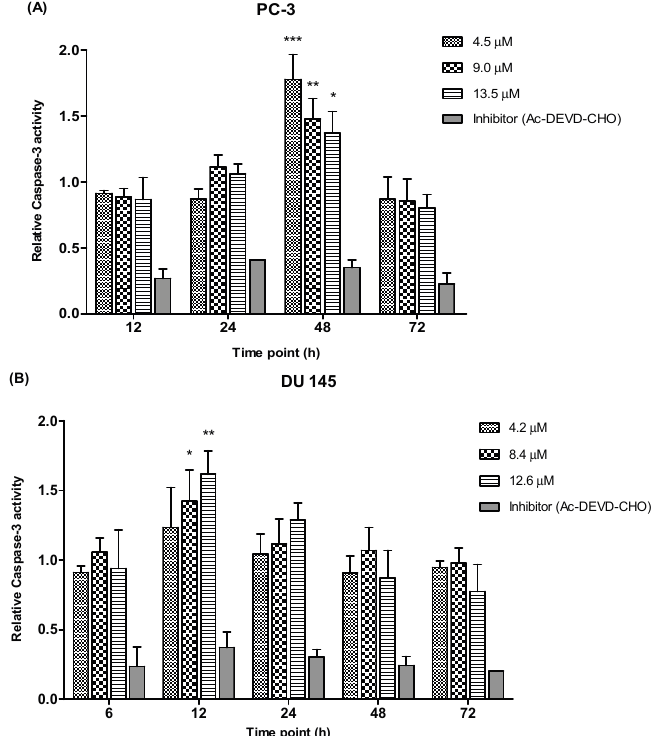
Figure 9. Relative caspase-3 activity in ( A ) PC-3 and ( B ) DU 145 cells treated with MS17 for 12, 24, 48 and 72 h. Results are expressed as mean ± S.E. from three independent experiments and comparison between data sets was performed using ANOVA. * p < 0.05, ** p < 0.01 and *** p < 0.001 indicates statistically significant differences between the means of values obtained with treated vs. control. Caspase-3 inhibitor, Ac-DEVD-CHO was used as a control to determine the inhibitory activity of